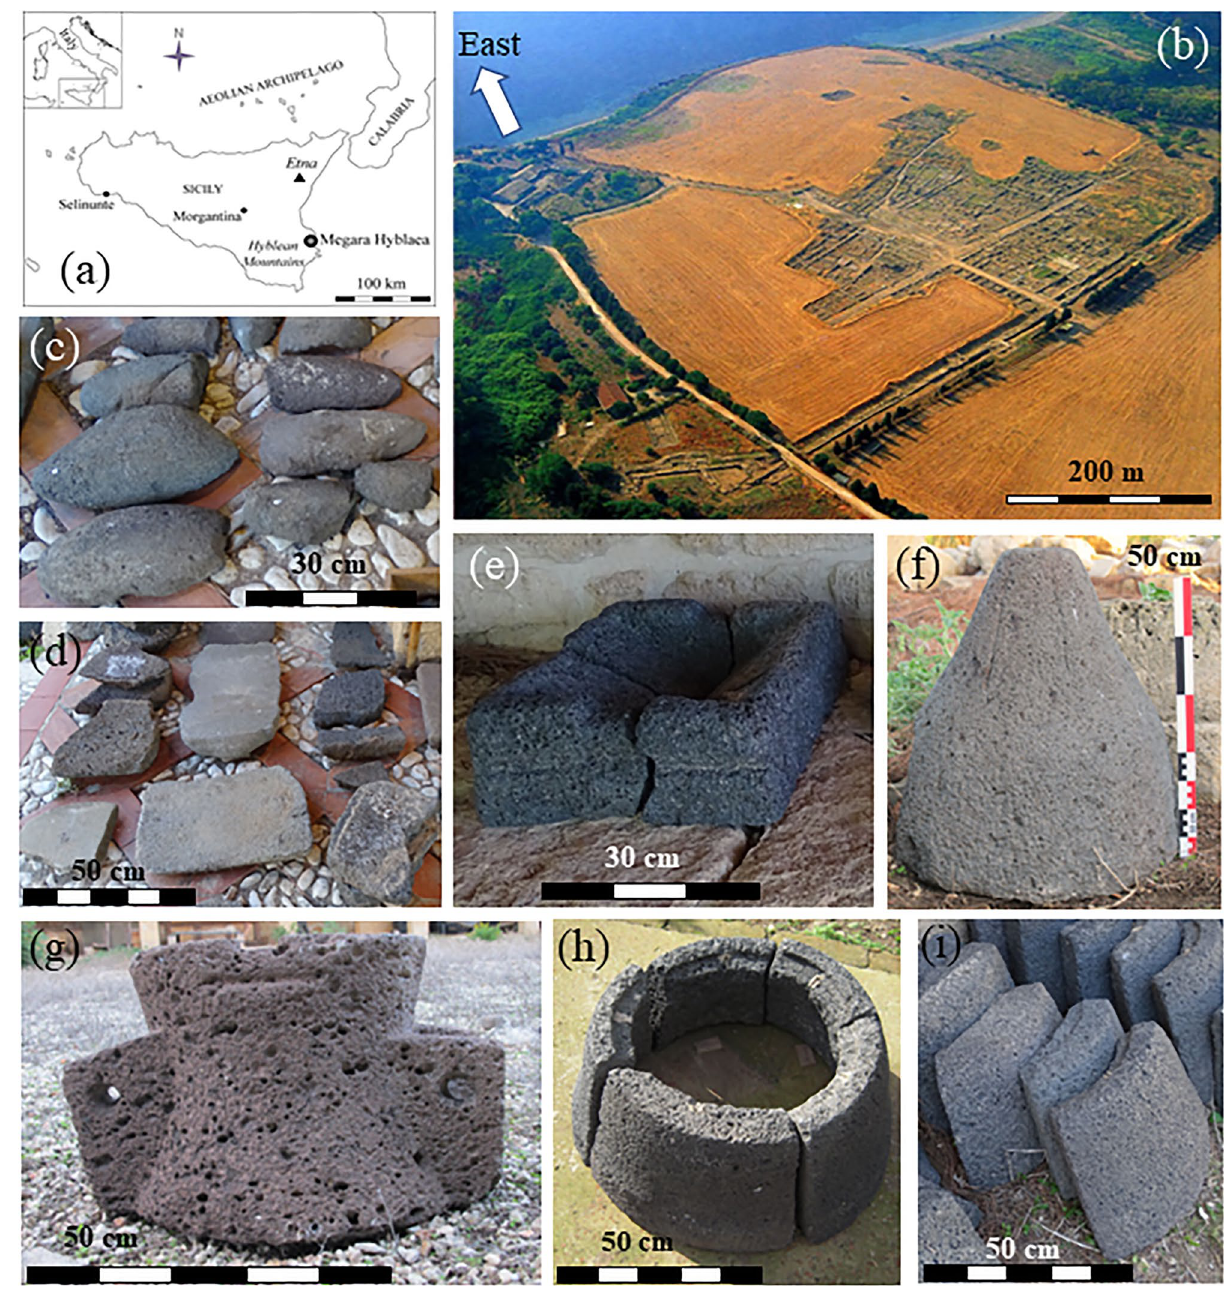
Figure 1. Location of Megara Hyblaea in the Sicily map ( a ) and aerial view of the archaeological site ( b ). Representative millstones: saddle-querns upper ( c ) and lower ( d ) portions; rectangular hopper-rubber ( e ); rotary Morgantina-type meta ( f ) and catillus ( g ); assembled catillus (upside down) of a composite Delian millstone ( h ) and relative isolated elements ( i